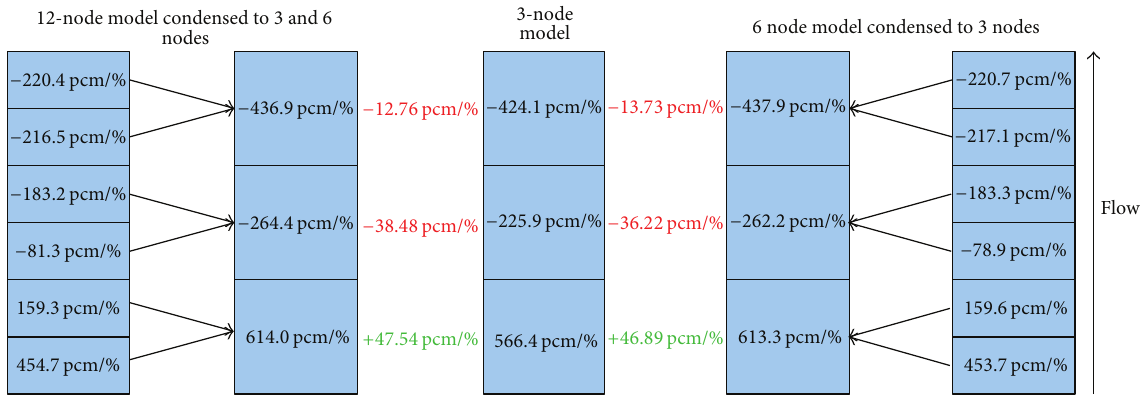
Figure 5: Decomposition of total VRC values to values for separate nodes. Comparison with 3-node model.